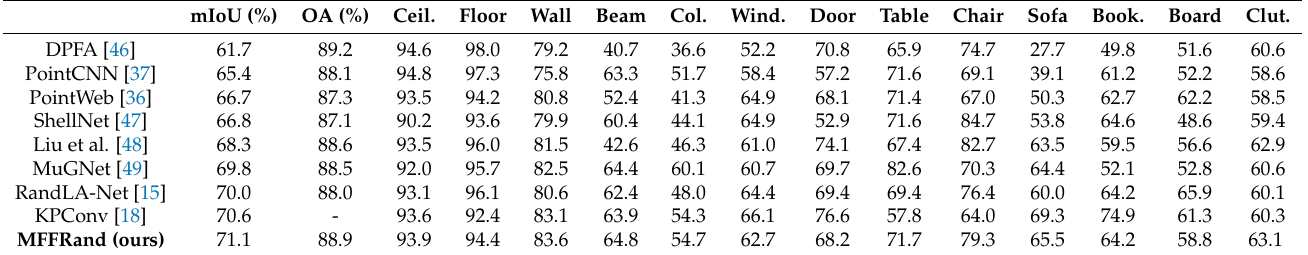
Table 1. Quantitative results of different networks on the S3DIS (6-fold cross-validation).